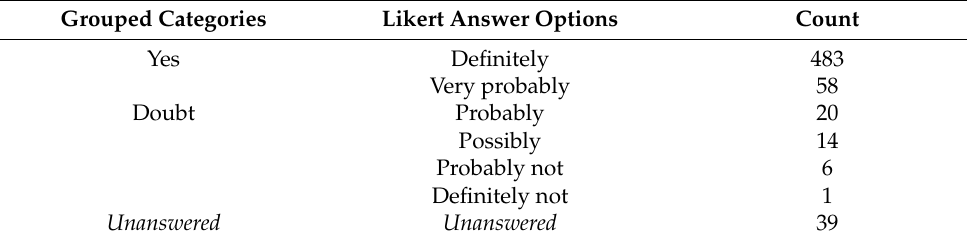
Table 3. Pet owner responses to the question ‘Do you think ferrets can experience boredom?’. During data cleaning, the Likert answer options were grouped into the categories ‘Yes’ and ‘Doubt’.